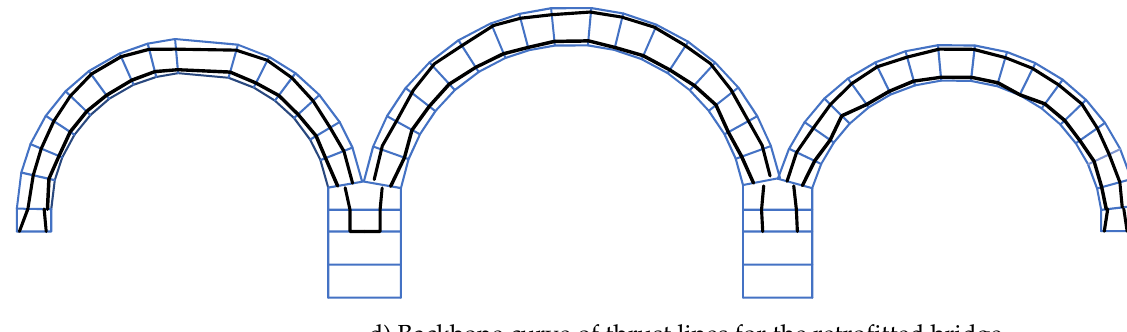
Figure 13. Line of thrust for the existing and retrofitted bridges under Erzincan EQ (EW)